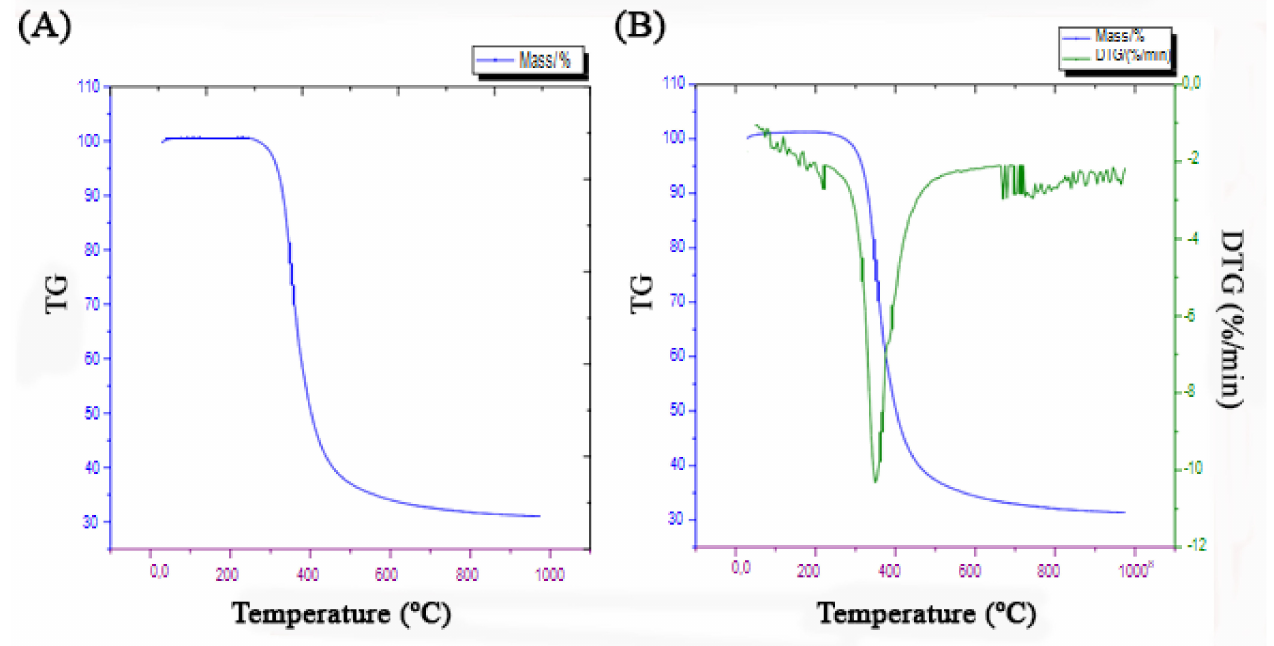
Figure 7. TG ( A ) and DTG ( B ) curves for the piperine crystal sample. In Figure 7B, which corresponds to the TG derived from the variation in mass as a function of temperature (green line on the graph), the occurrence of a series of secondary or minor reactions close to the primary response during the entire heating process